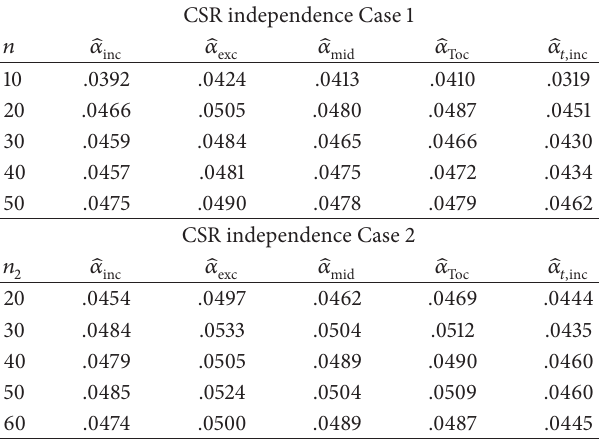
Table 4: The empirical significance levels for Fisher’s two-sided exact tests for the 𝑄 -symmetry contingency tables under CSR independence Cases 1 and 2 with 𝑁 mc is for mid- 𝑝 value version, and ̂𝛼 is table-exclusive version, ̂𝛼 mid Toc for Tocher corrected